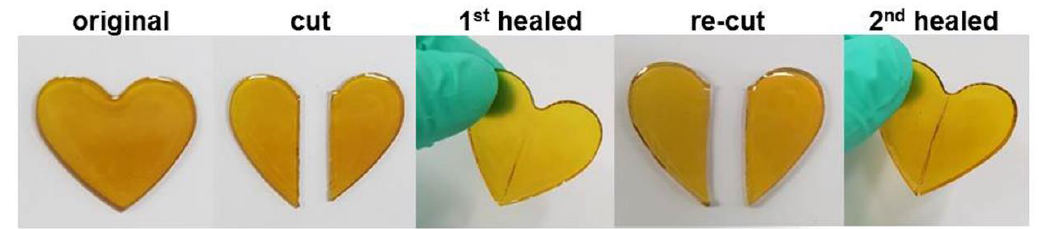
Figure 8. Confirmation of self-healing using FEEMA64_mGO0.030 wt%.